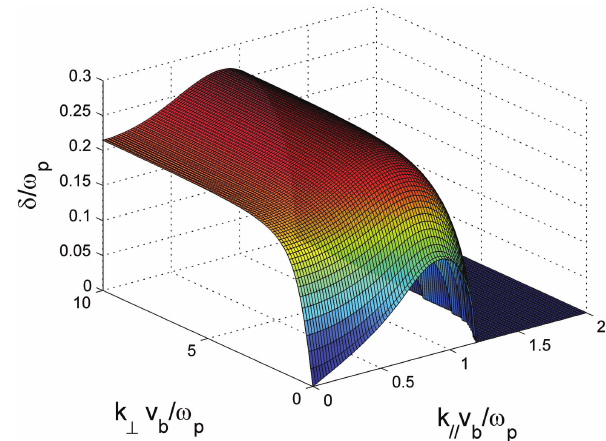
Fig. 1. Growth-rate map for v b = 0 . 9 c and n b /n p = 1 / 10. The fastest growing modes are not found aligned with a privileged axis. The background plasma electronic frequency reads ω p .